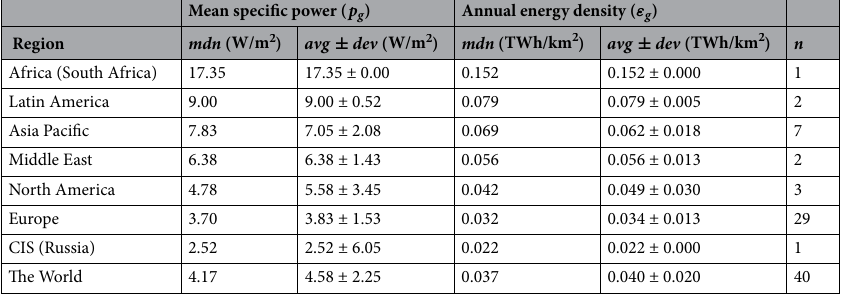
Table 9. Mean and annual power and energy densities of residential solar PV systems in the different regions based on the estimated cumulative data for each country 5